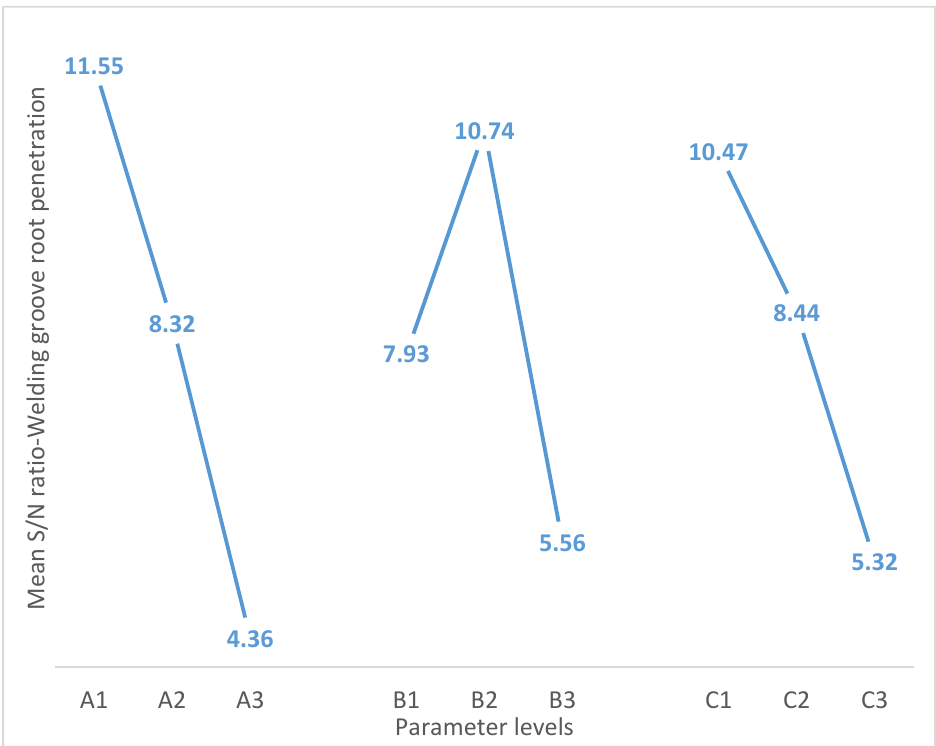
Figure 9. S/N ratio vs. parameter levels for weld bead root penetration. The values of the S/N ratio were averaged for the different levels established for welding root penetration. Table 7 reveals these mean values as well as the difference between the maximum and minimum values. The total average of the S/N ratio is 8.08 dB.